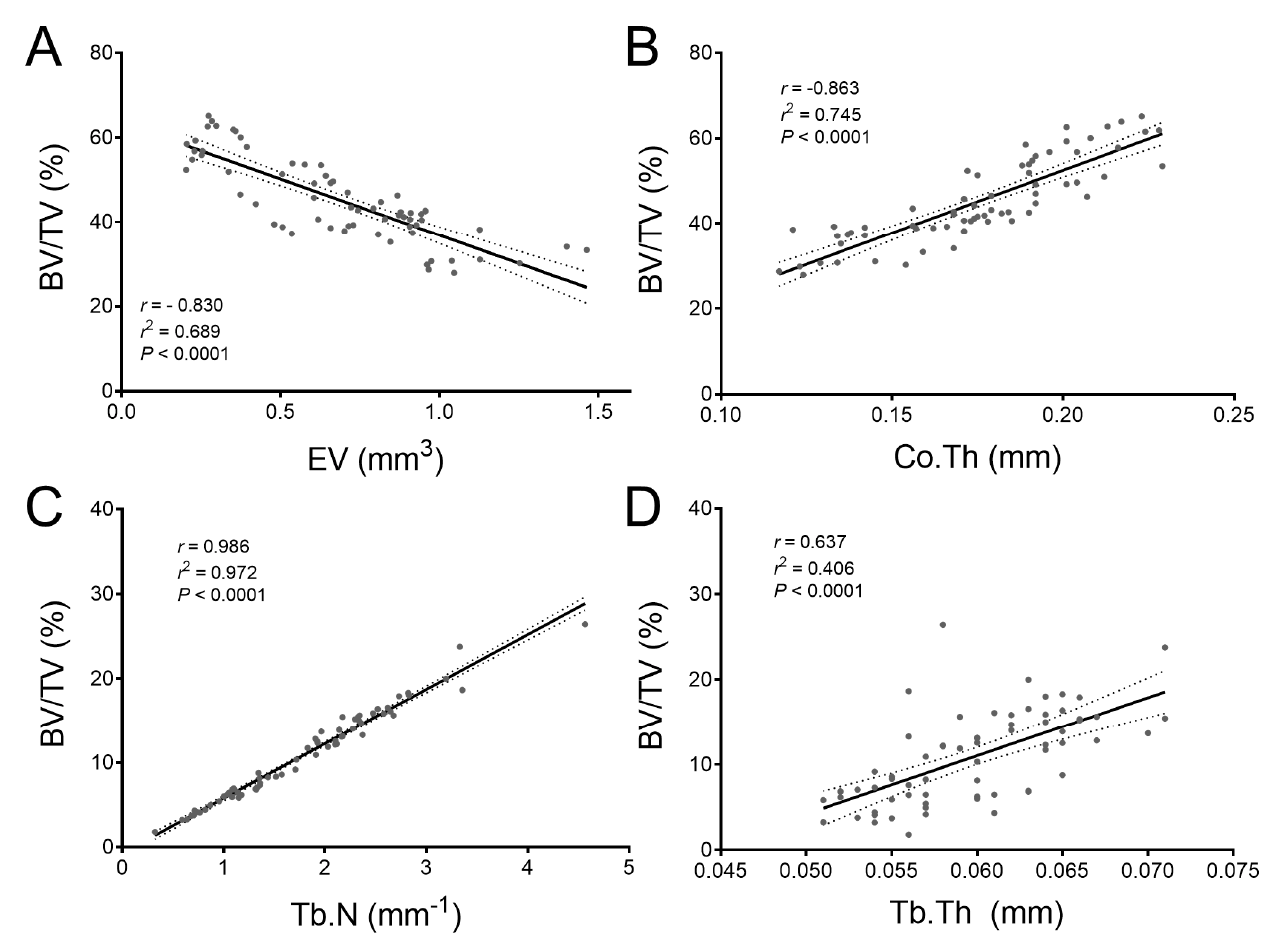
Figure 7. Scatter plots showing correlation between BV/TV and other morphometric parameters. ( A ) EV. ( B ) Co.Th. ( C ) Tb.N. ( D ) Tb.Th. The full line represents the line of best fit derived from simple linear regression, while the dotted lines represent the 95% confidence